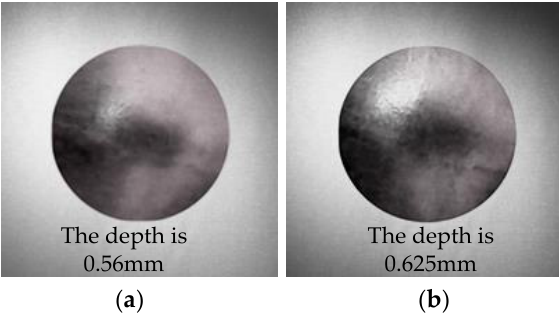
Figure 13. Drawing deep samples ( a ) untreated material; and ( b ) ADCT3.